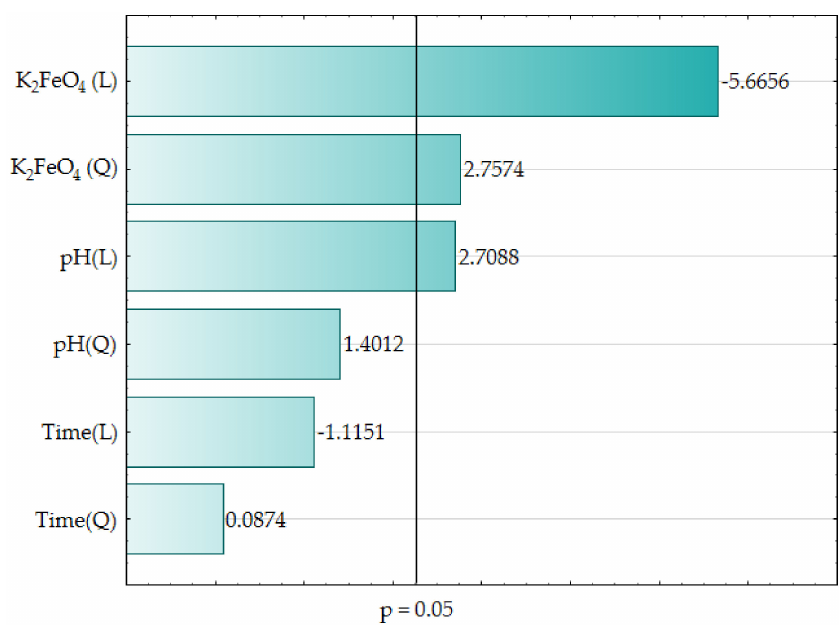
Figure 1. Bar chart of standardized e ff ects (COD, g O 2 / L, 3 value, 1 block, 16 experiments, MS = 0.0040, L–linear e ff ect, Q–quadratic e ff ect, p–the absolute value of the standardized e ff ect evaluation).